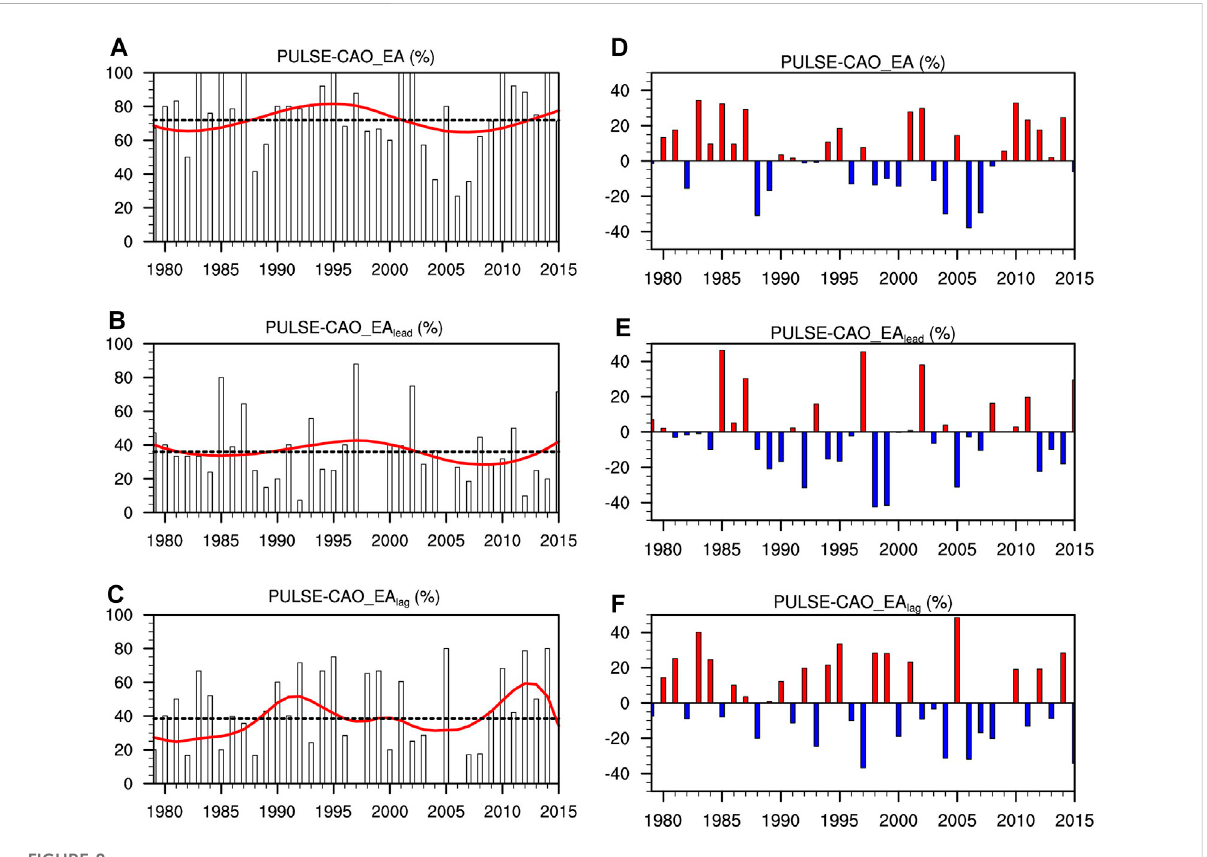
FIGURE 8 As in Figure 7, but for the coupling indices between CAO_EA and PULSE ( (A) , (D) PULSE-CAO_EA; (B) , (E) PULSE-CAO_EA lead ; and (C) , (F) PULSE-CAO_EA lag ).